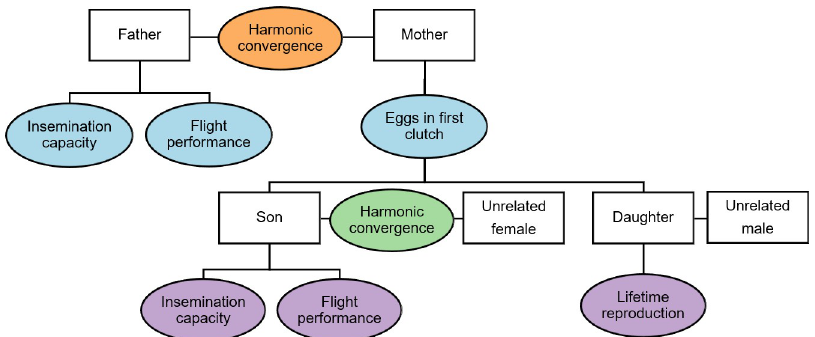
Fig 1. Overview of experiments. Flowchart illustrating the overall experimental design. Parental pairs were first tested for harmonic convergence. Father fitness was then assayed in either insemination capacity or flight performance assays and mother fitness was measured by first egg clutch size. Finally, sons were tested for harmonic convergence with unrelated females, followed by either insemination capacity or flight performance assays, while daughters were mated with unrelated males and their lifetime reproductive fitness tracked using a life table